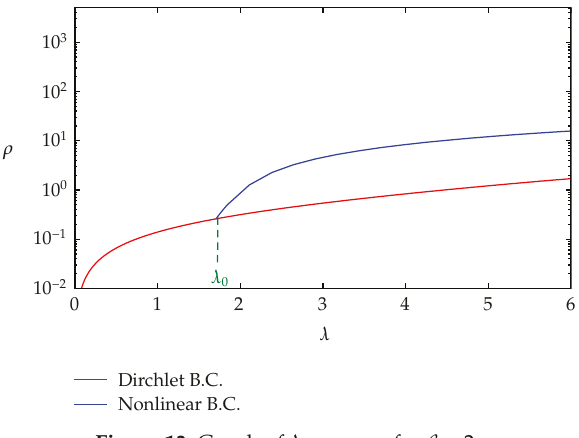
Figure 13: Graph of λ versus ρ for β (cid:3) 2.